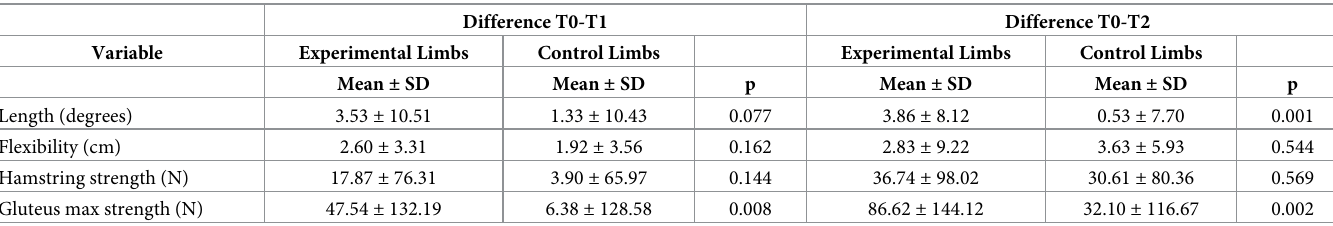
Table 3. Inter-group analysis.